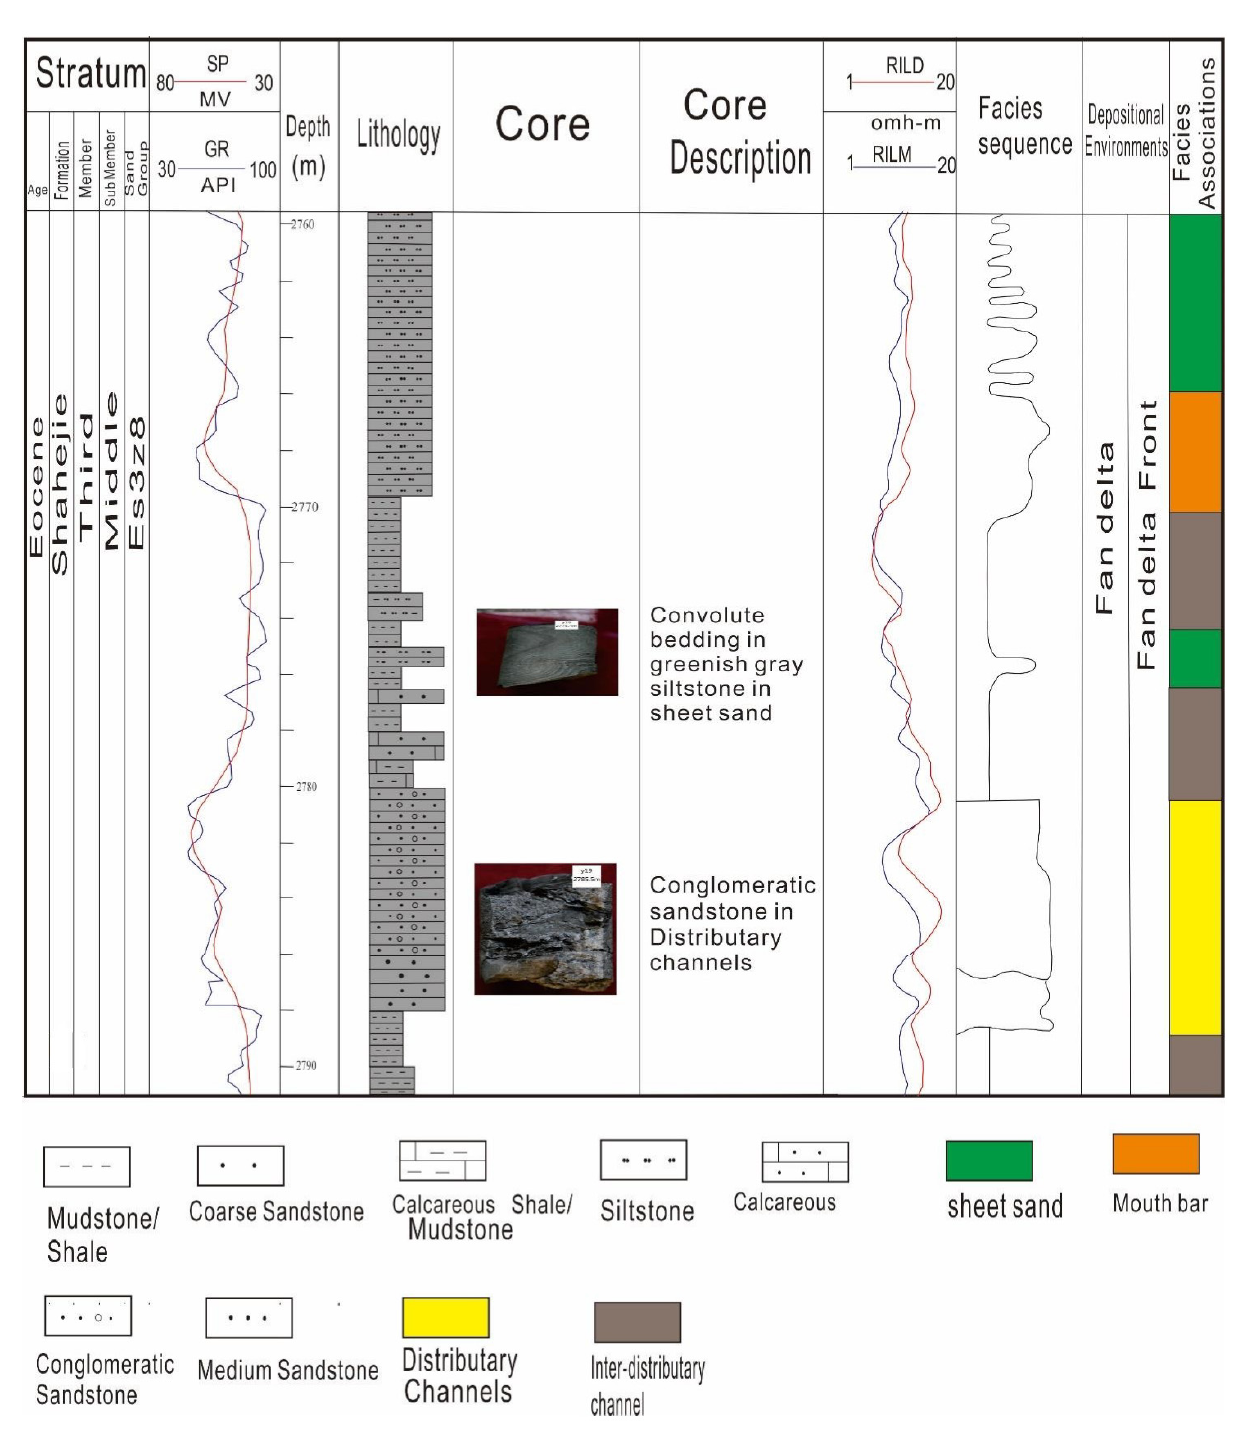
Figure 13. Core well Y19 in study area; convolute bedding in greenish gray siltstone (CBS); conglom- eratic sandstone in distributary